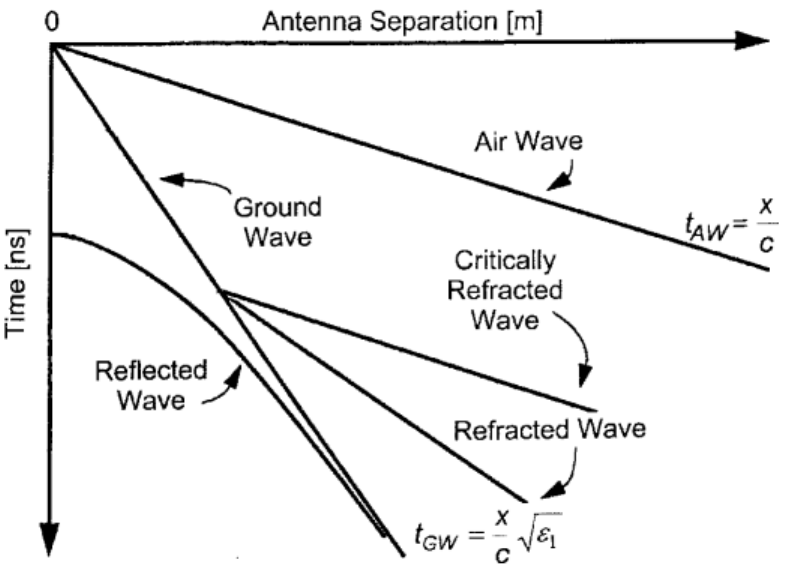
Figure 6. Schematic wide-angle reflection and refraction (WARR) measurement. Adapted with permission from [22]. Copyright 2003, Wiley.